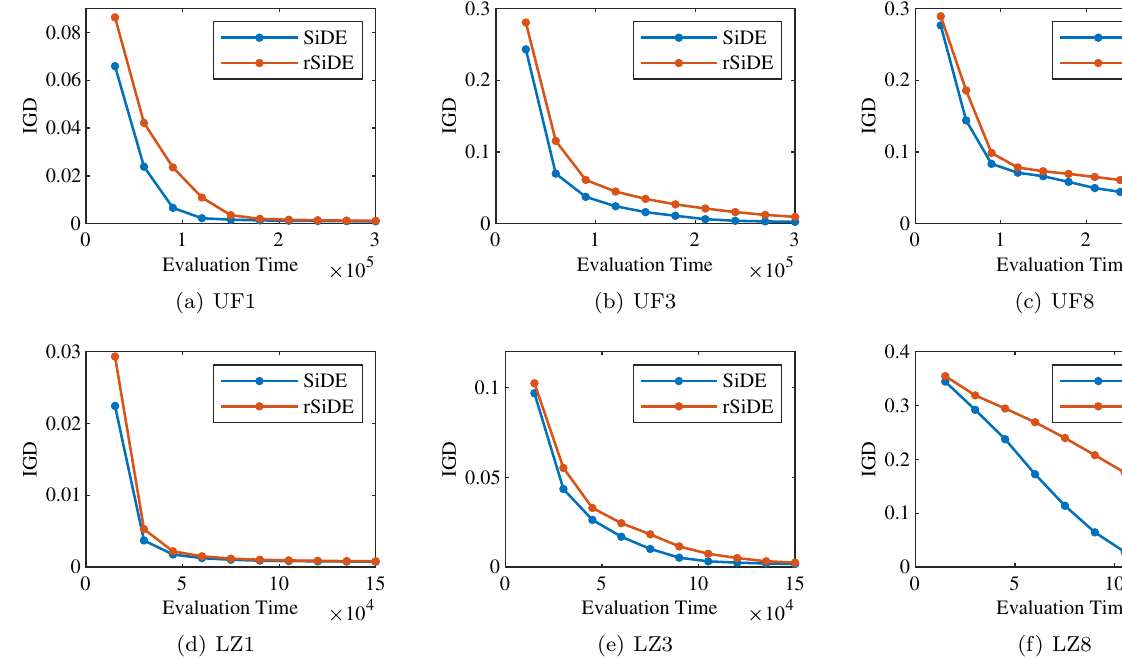
Fig. 8 The average IGD values in 30 runs produced by two algorithms at each time